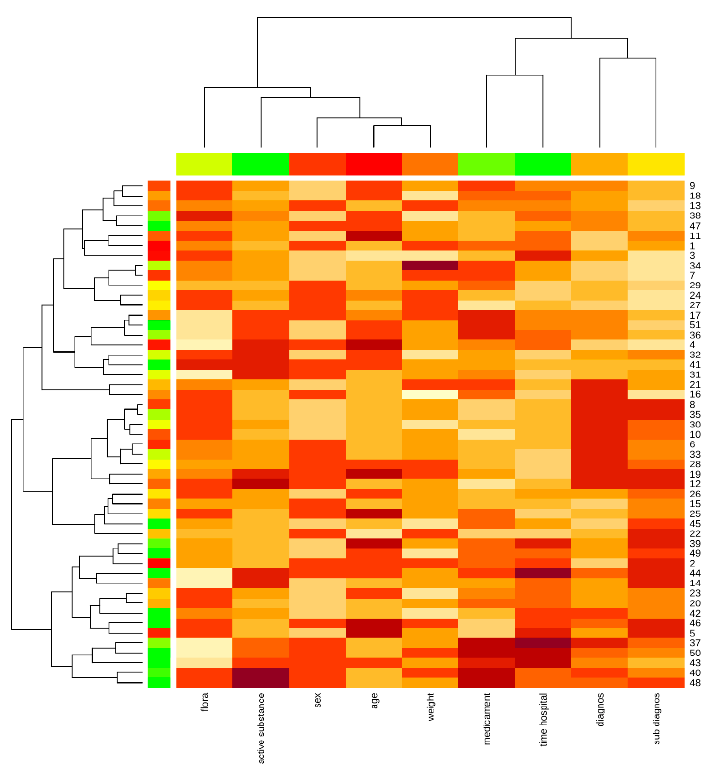
Figure 5. Patient placement in the component space.